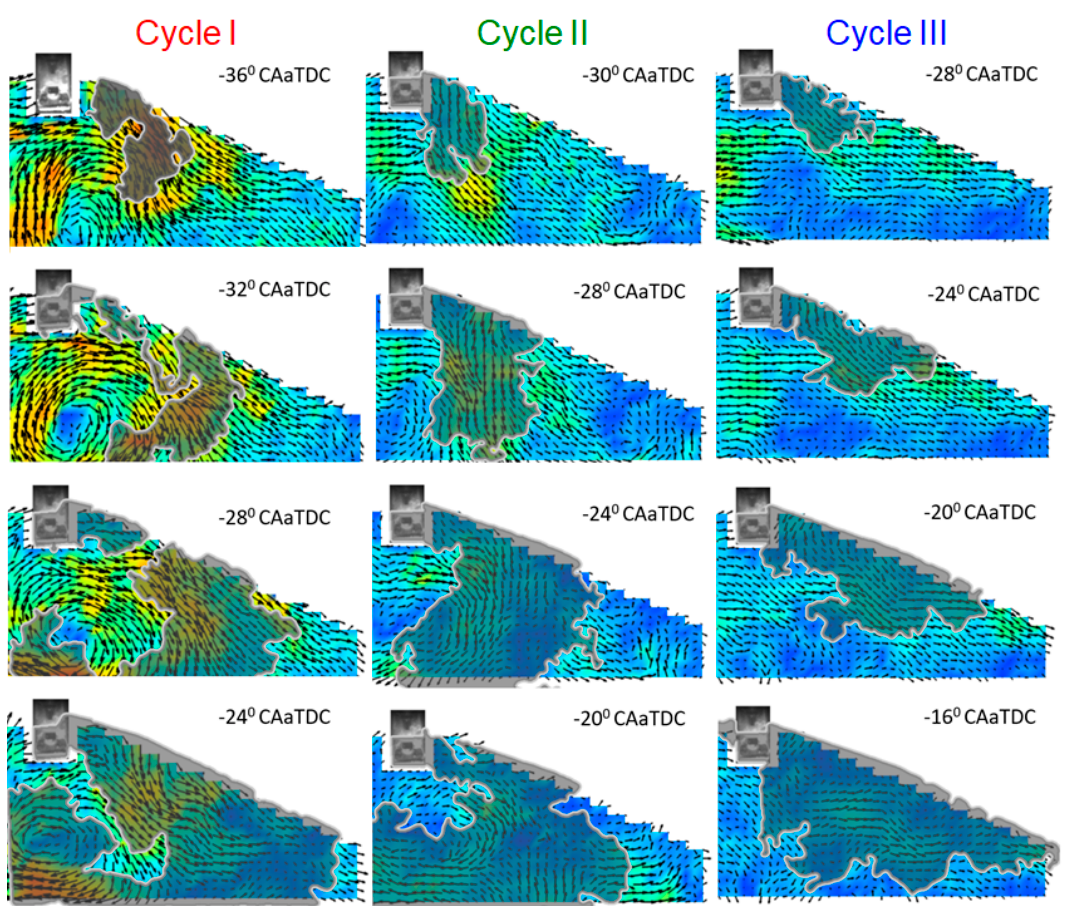
Figure 6. PIV-flame-development images after initial kernel development of three selected cycles (I, II, and III) at 1200 rpm condition.